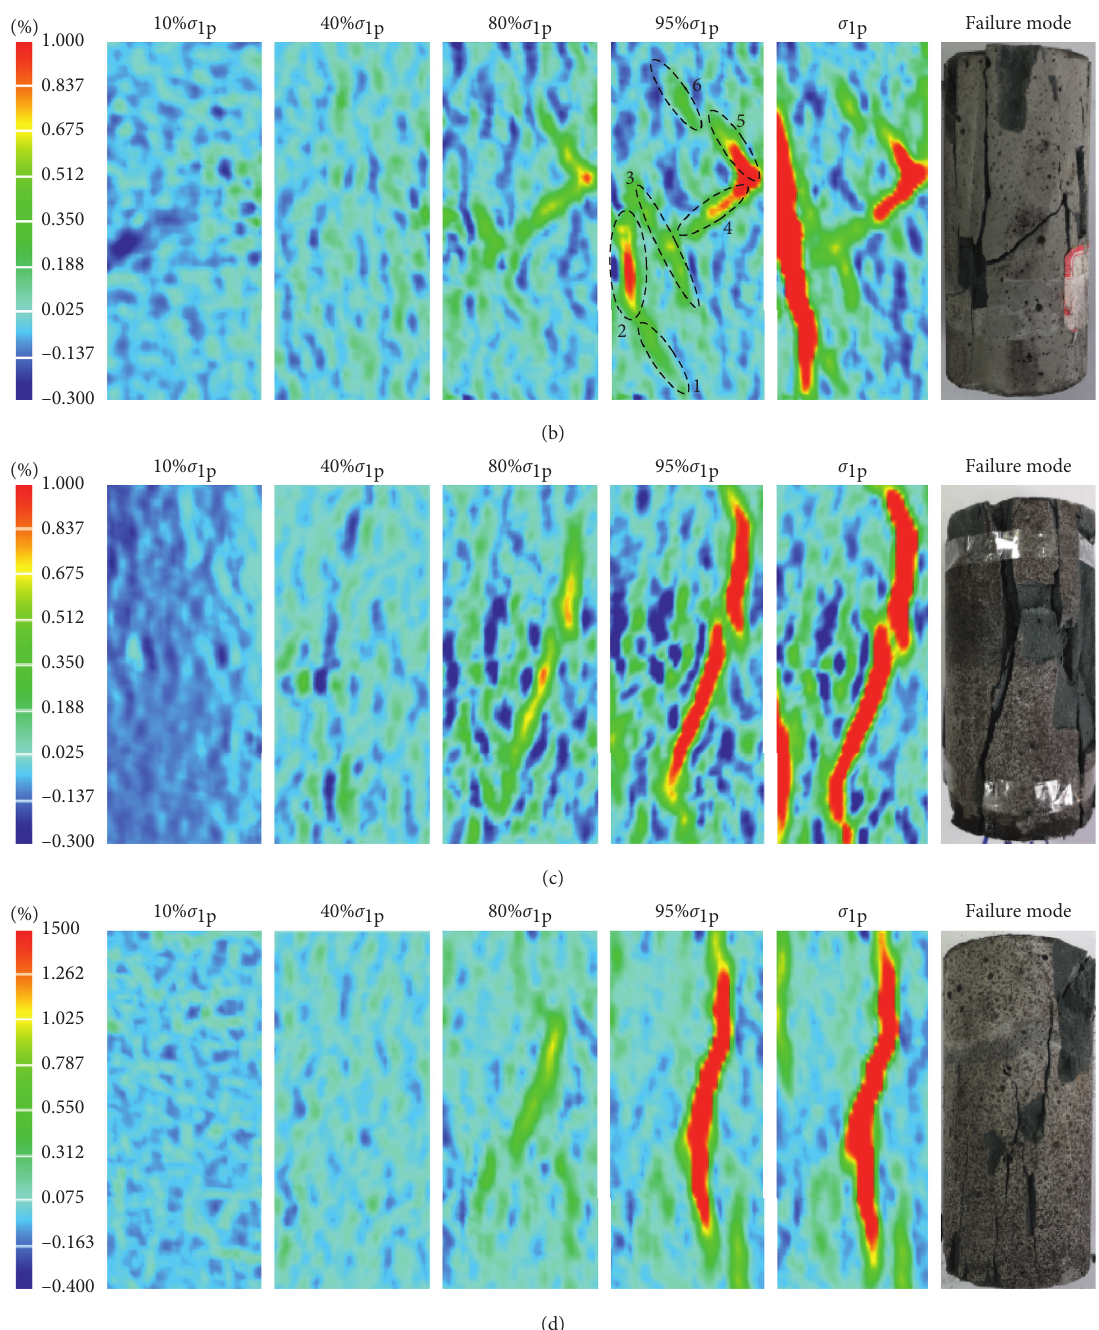
Figure 10: Evolution process of strain fields of specimens containing closed 3D-printing rough joints with different joint inclinations under uniaxial compression ( l � 40.0mm). (a) Specimen T30-2# ( α � 30 ° ), (b) specimen T45-2# ( α � 45 ° ), (c) specimen T60-2# ( α � 60 ° ), and (d) specimen T90-1# ( α � 90 °